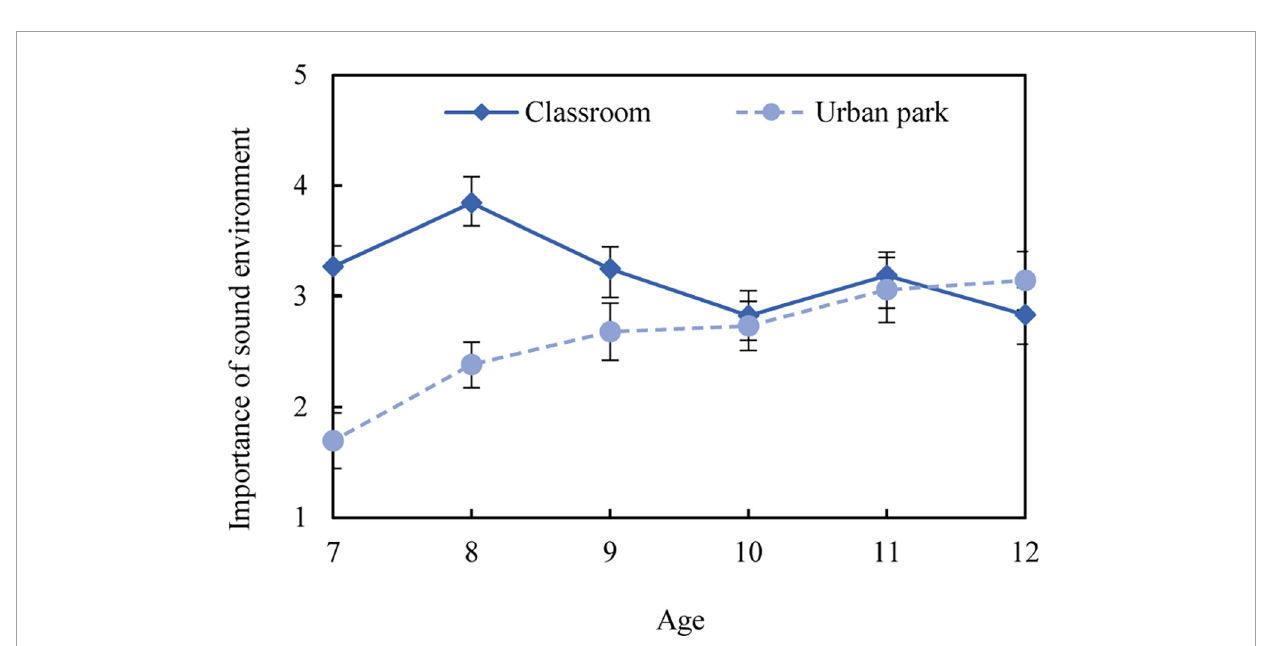
FIGURE7 The importance of a sound environment in children’s restorative